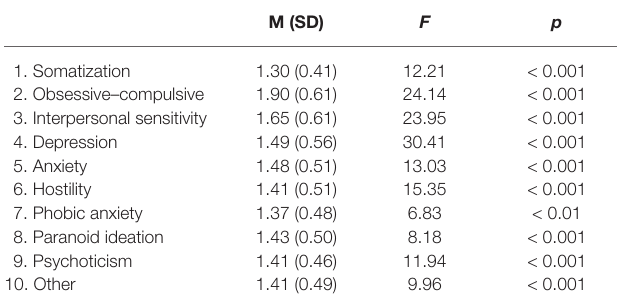
TABLE 3 | One-way ANOVA of SCL-90